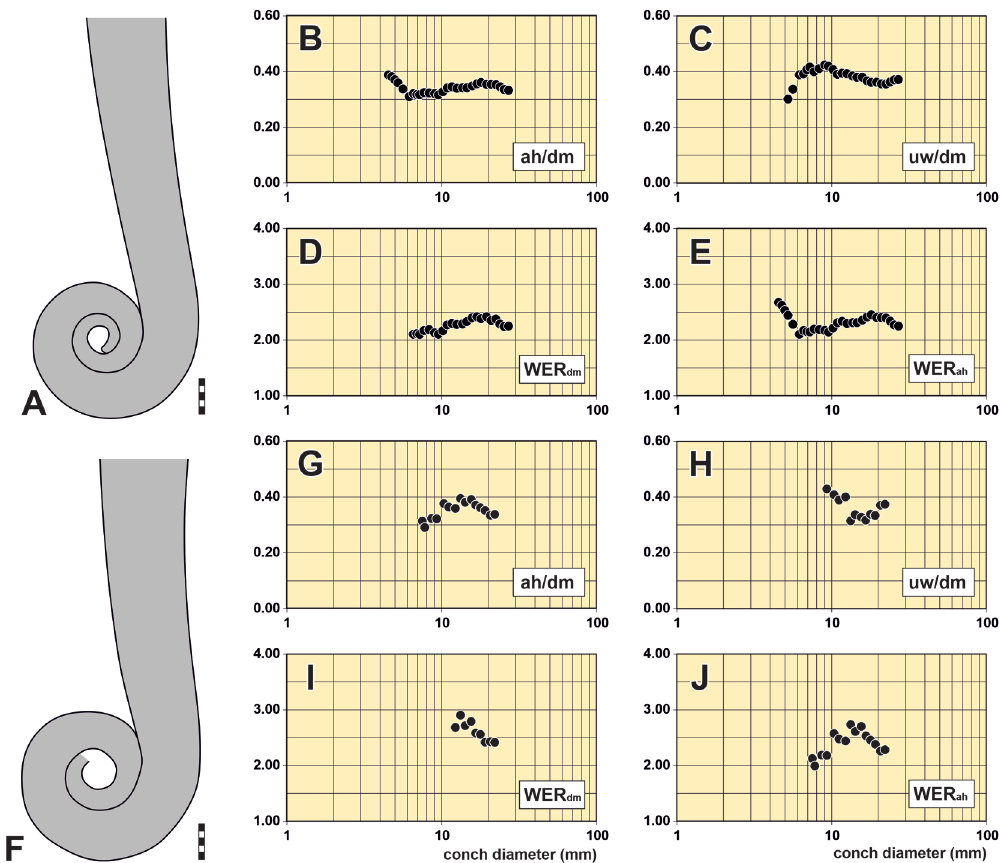
Fig. 36. Lituites cf. lituus de Montfort, 1808. A . Outline of coiled conch part of specimen MB.C.30529. B–E . Conch proportions and coiling rates of specimen MB.C.30529. F . Outline of coiled conch part of specimen MB.C.30530. G–J . Conch proportions and coiling rates of specimen MB.C.30530. Scale bar units = 1